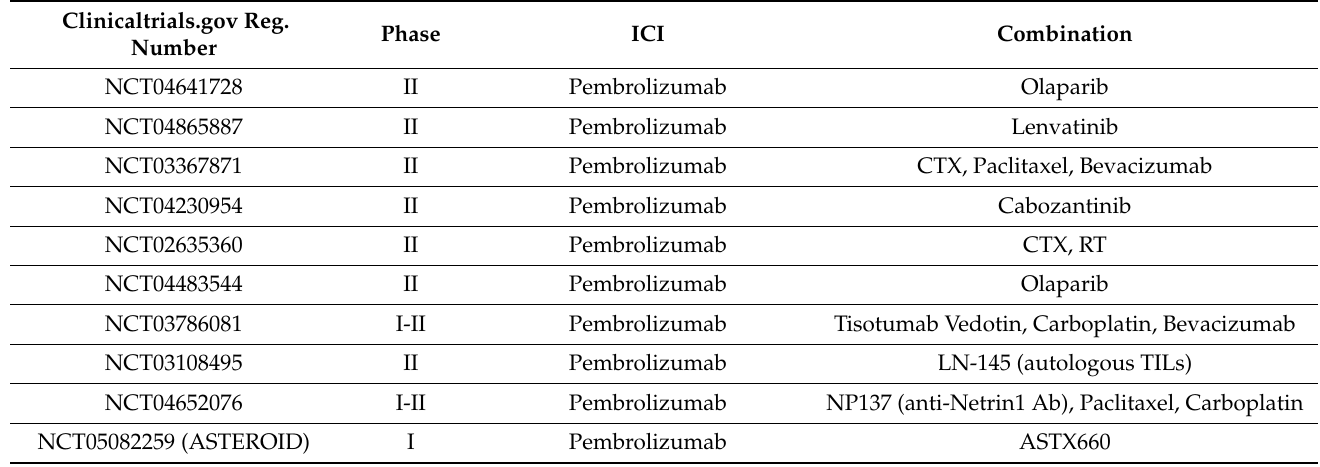
Table 3. Ongoing trials on ICIs and combinations in advanced/recurrent CC. Clinicaltrials.gov